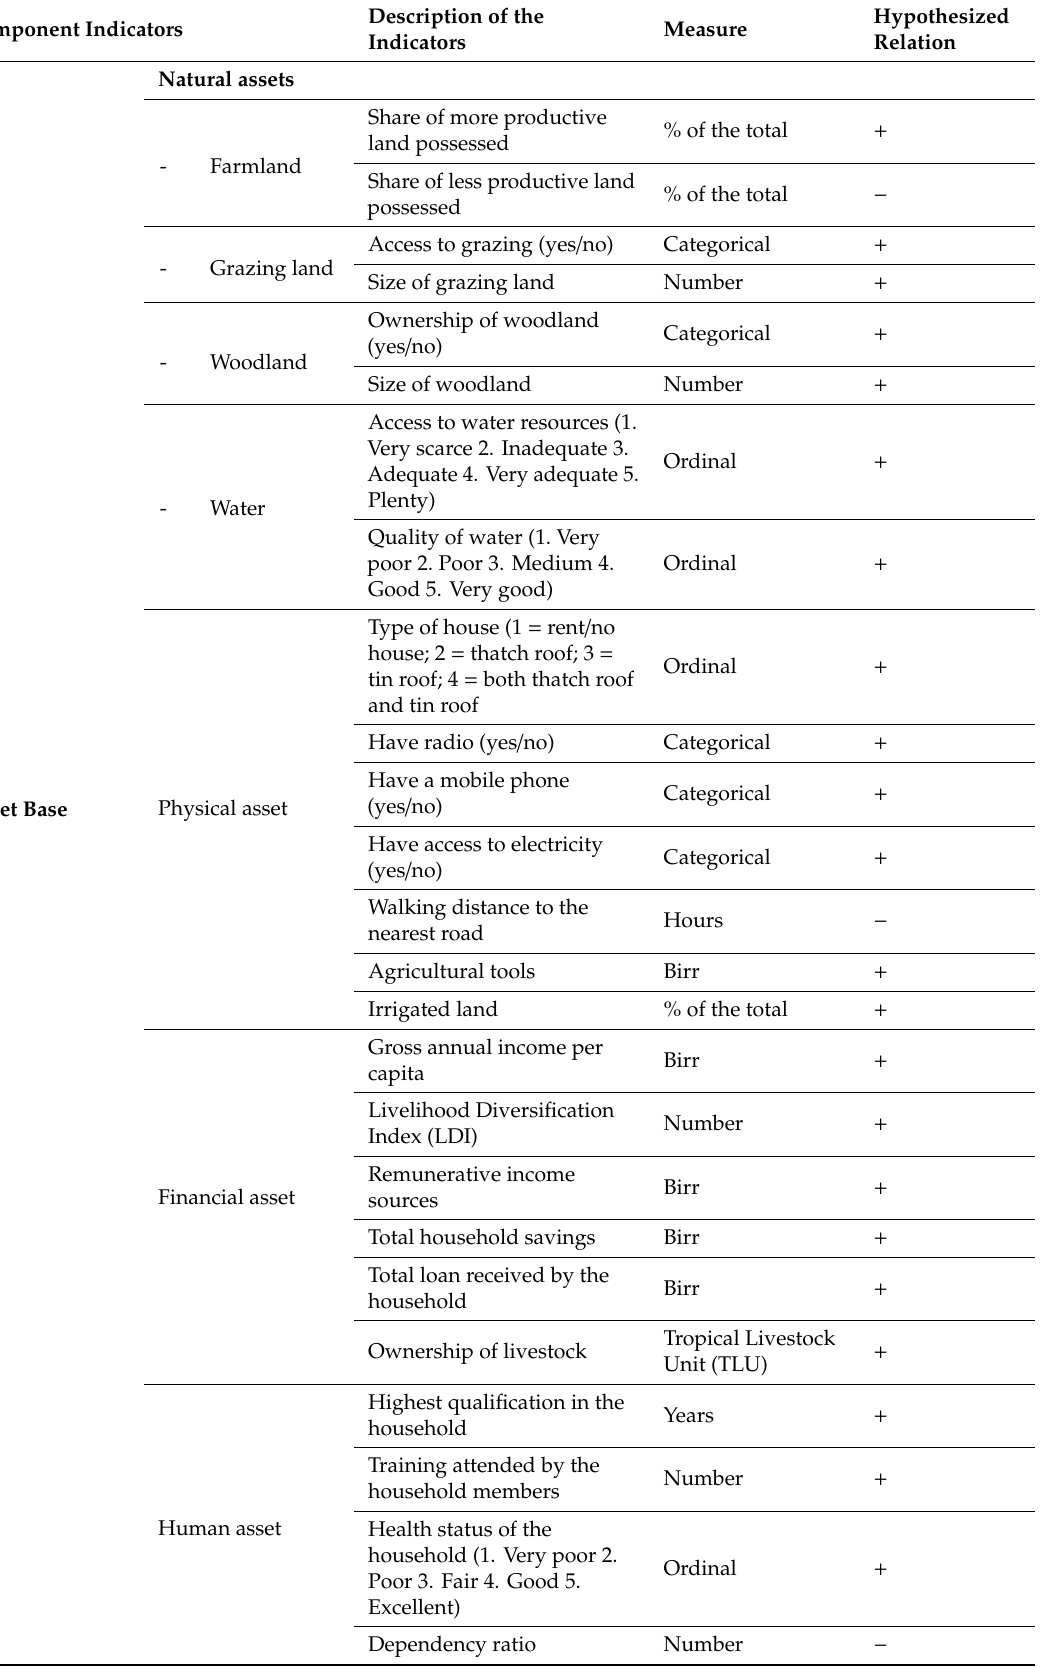
Table 1. Dimensions and indicators of adaptive